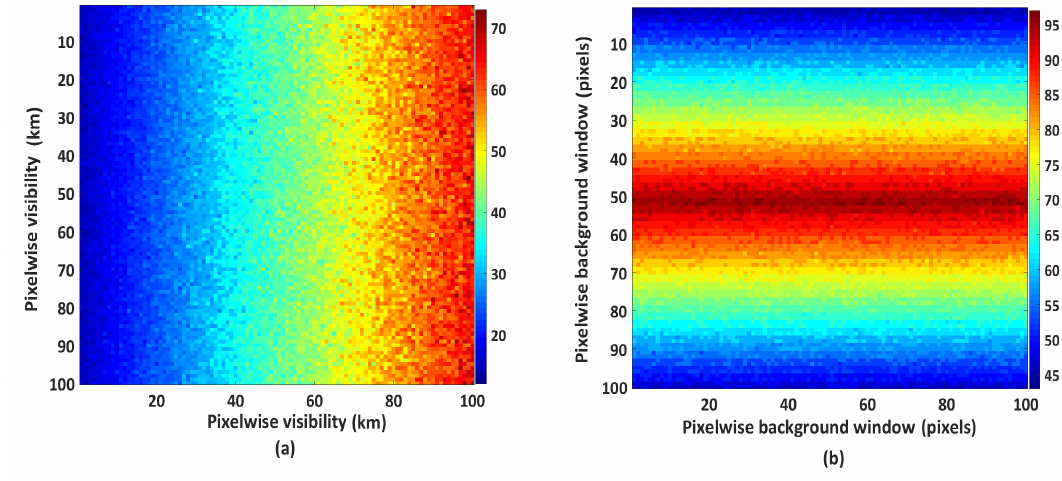
Figure 10. Spatial variability of visibility ( a ) and the background window ( b ) used in forward modeling, serving as the true values for result